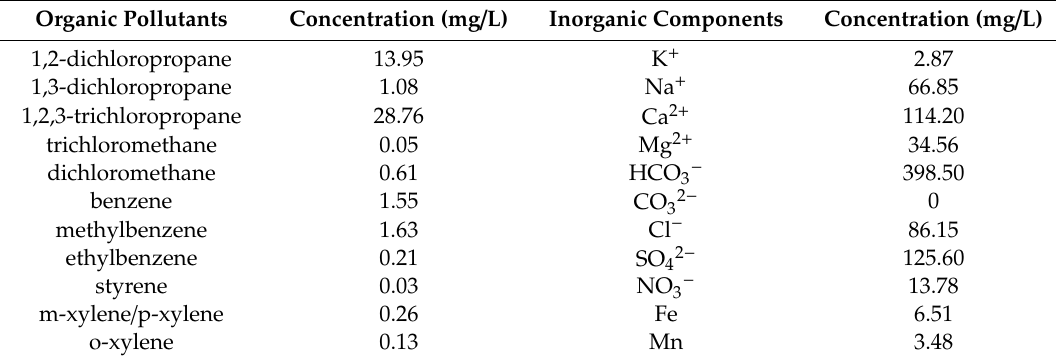
Table 1. Chemical analysis of groundwater in the pollution source